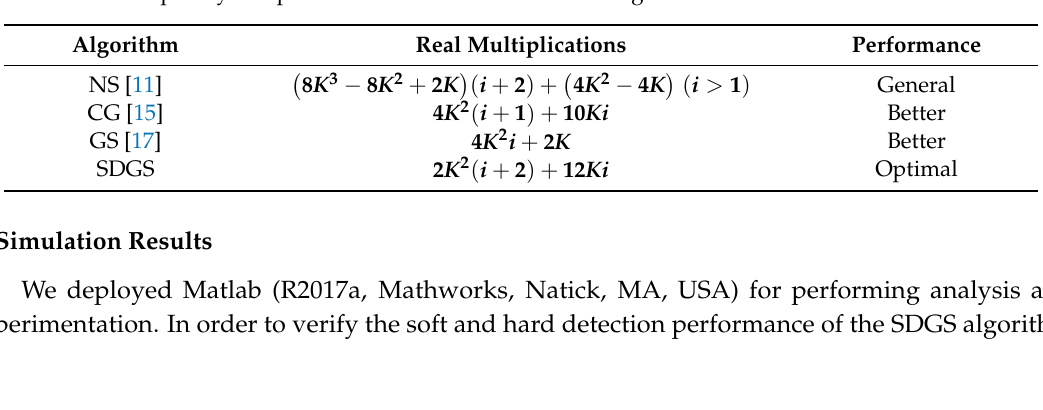
Table 1. Complexity comparison of four kinds of detection algorithms for hard decision